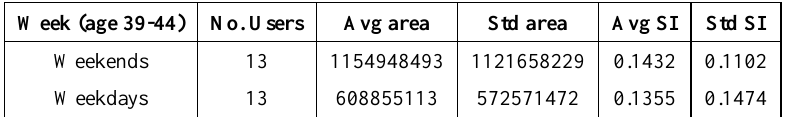
Table 9. Average and standard deviation of area and shape index of users between 39-44 based on days of the week.